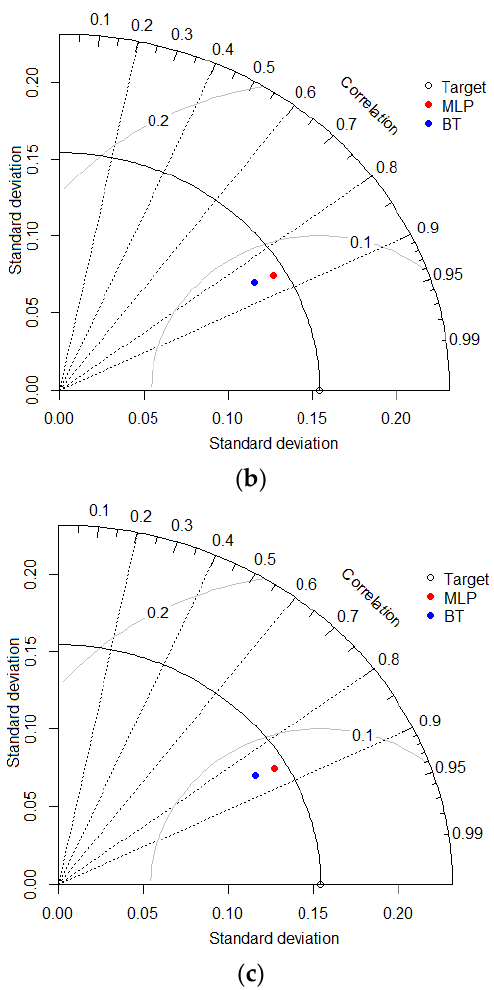
Figure 10. Taylor diagram for Co ( a ), Cu ( b ) and Pb ( c ) based models. The colored dots epitomize the models in the corresponding legend.